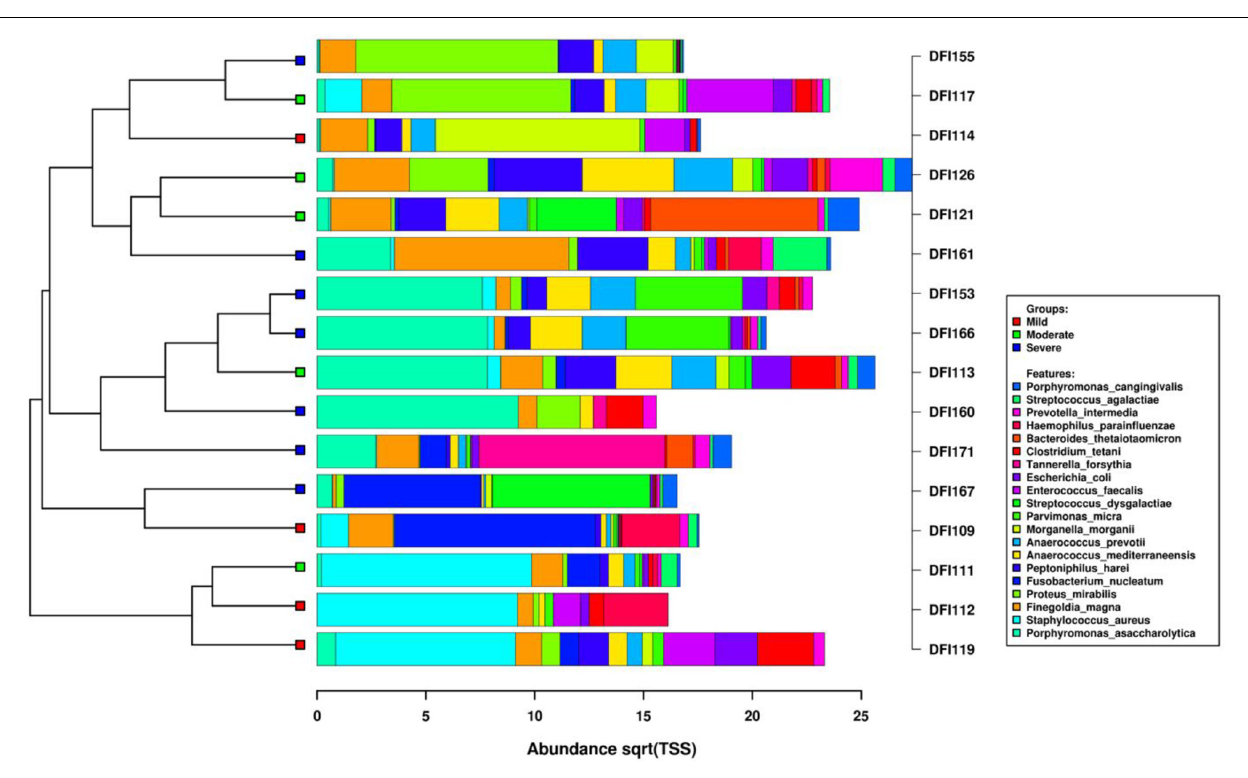
FIGURE 4 | Clustered bar chart of the top 20 active bacterial species. The dendrogram was calculated using the hierarchical clustering of Bray–Curtis distances including the top 20 species assigned using Kraken. The horizontal axis is the square root abundance of the identified